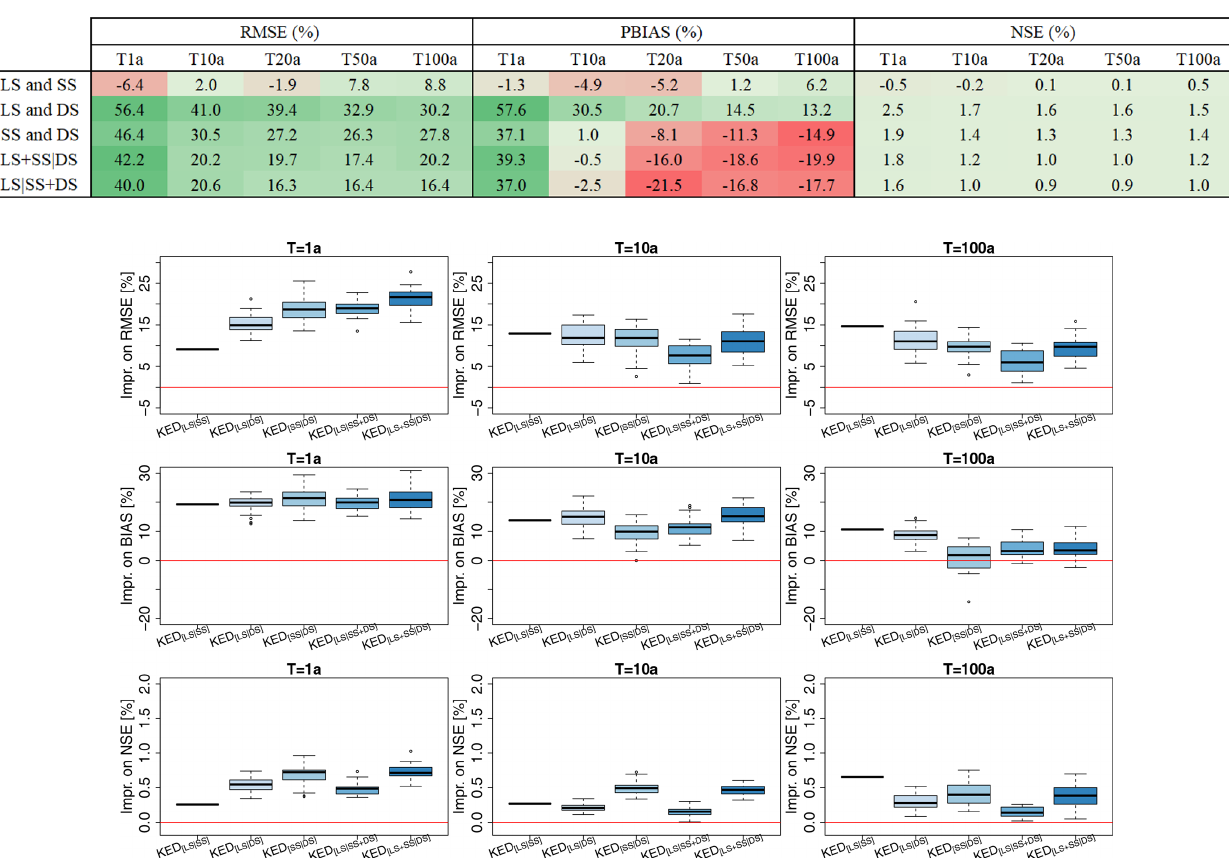
Table 10. Median difference between external drift kriging (KED) and ordinary kriging (OK) improvements calculated for different data as per Eq. (15). The median is computed from 133 stations. The data used as input are short series (SS), long series (LS) and disaggregated daily series (DS) and combined either with same importance ( + ) or with priority importance ( | ). The positive difference shown in green shades indicates that KED introduces bigger improvements towards the benchmark than the OK. The negative differences shown in red shades indicate that the OK regionalisation has the bigger improvements.